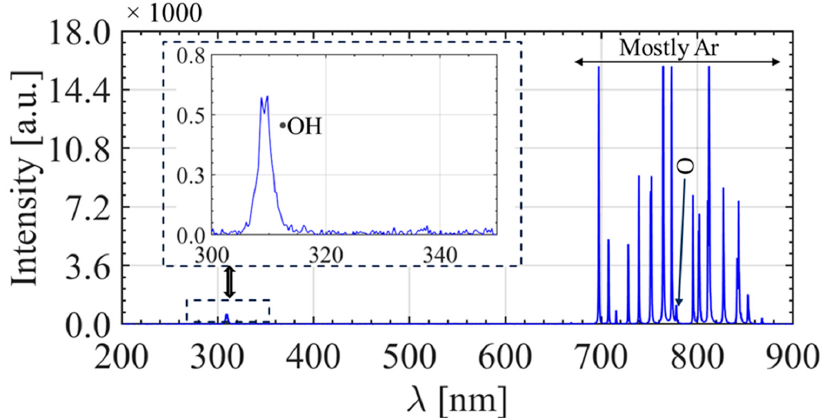
Figure 5. Optical emission spectra of the plasma jet recorded at 20 mm below the end of the second ground electrode (integration time = 70